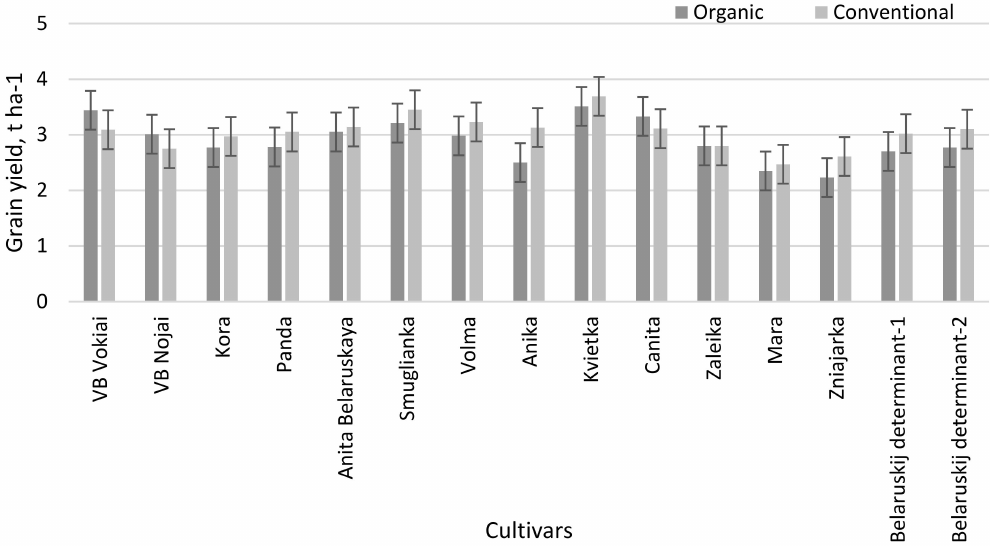
Figure 2. Grain yield of buckwheat cultivars in different farming systems (LSD 05(AxB) =